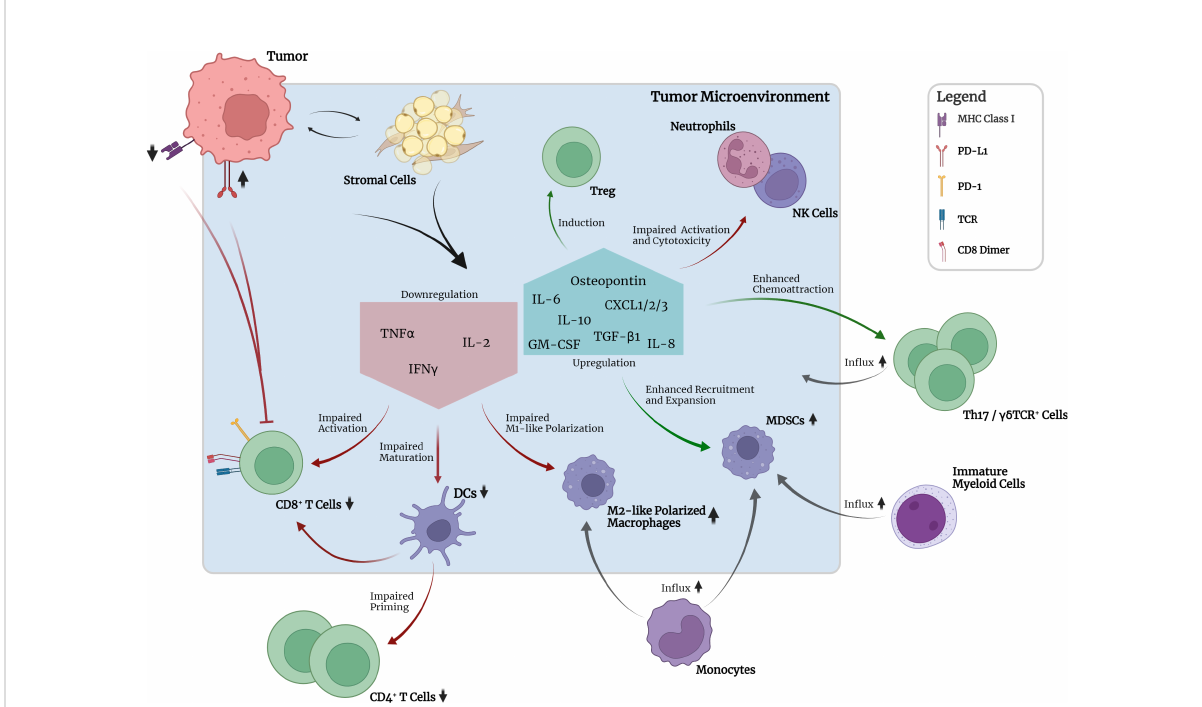
FIGURE 2 Crosstalk between tumor, TME and selected immune cell types in the absence of pharmacological interruption. Mutant KRAS-associated downregulation of MHC class I molecules and increased expression of PD-L1 on tumor cells leads to reduced detectability and pronounced inhibition of CD8+ T cells. Crosstalk between tumor and stromal cells leads to downregulation of pro-in fl ammatory cytokine expression, e.g., TNF a , IL-2, and IFN g , by stromal cells. Consequently, activation of CD8+ T cells, maturation of DCs and M1 polarization of macrophages are impaired. Subsequent priming of CD4+ T cells is impaired. Upregulation of IL-10 and TGF- b 1 leads to induction of suppressive peripheral Treg. GM-CSF in the TME together with tumor-secreted osteopontin leads to recruitment and expansion of immunosuppressive myeloid- and monocyte-derived MDSCs. Upregulated expression of chemokines leads to chemoattraction of Th17 and gd TCR+ cells which have been implicated in promotion of tumor cell proliferation and angiogenesis. Neutrophil and NK cell function seem to be impaired regarding activation and cytotoxicity. Upregulation of IL-6 production promotes cell survival and establishment of an in fl ammatory microenvironment required for optimal tumor